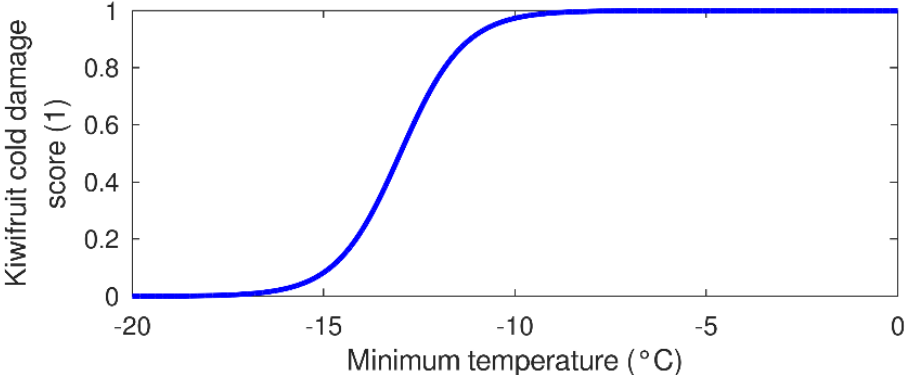
Figure 6 . Cane damage score for kiwifruit as a function of minimum temperature. A higher score indicates less cold damage.